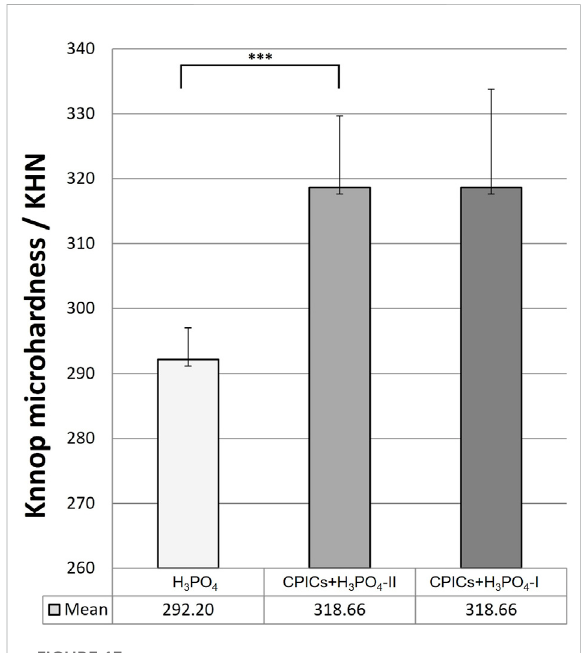
FIGURE 13 Microhardnessscoresfortheacid-etchedenamel.This fi gure presents the data in Table 6. Error bars represent the standard deviation of the mean. *** indicates signi fi cance at p <